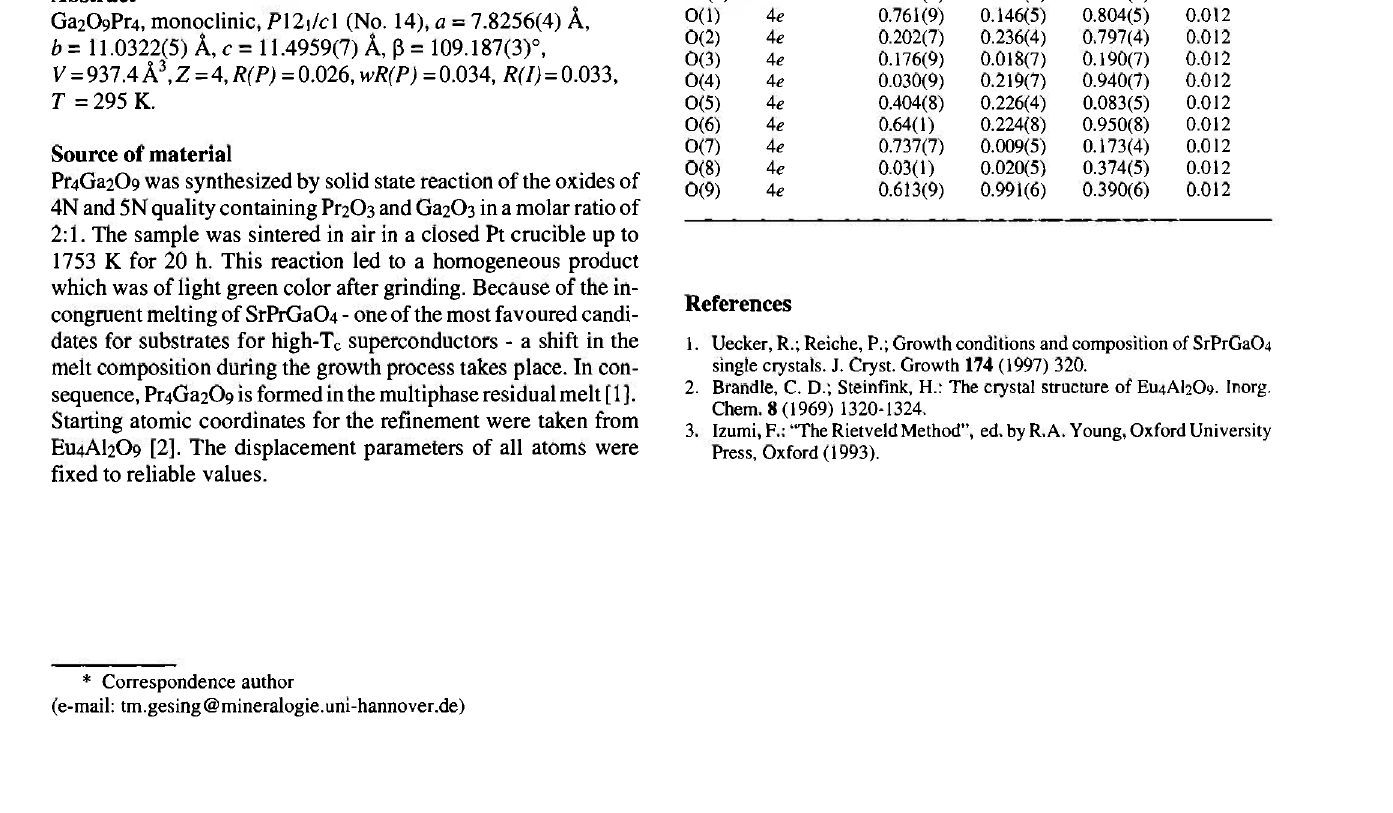
Table 2. Atomic coordinates and displacement parameters (in Ä 2